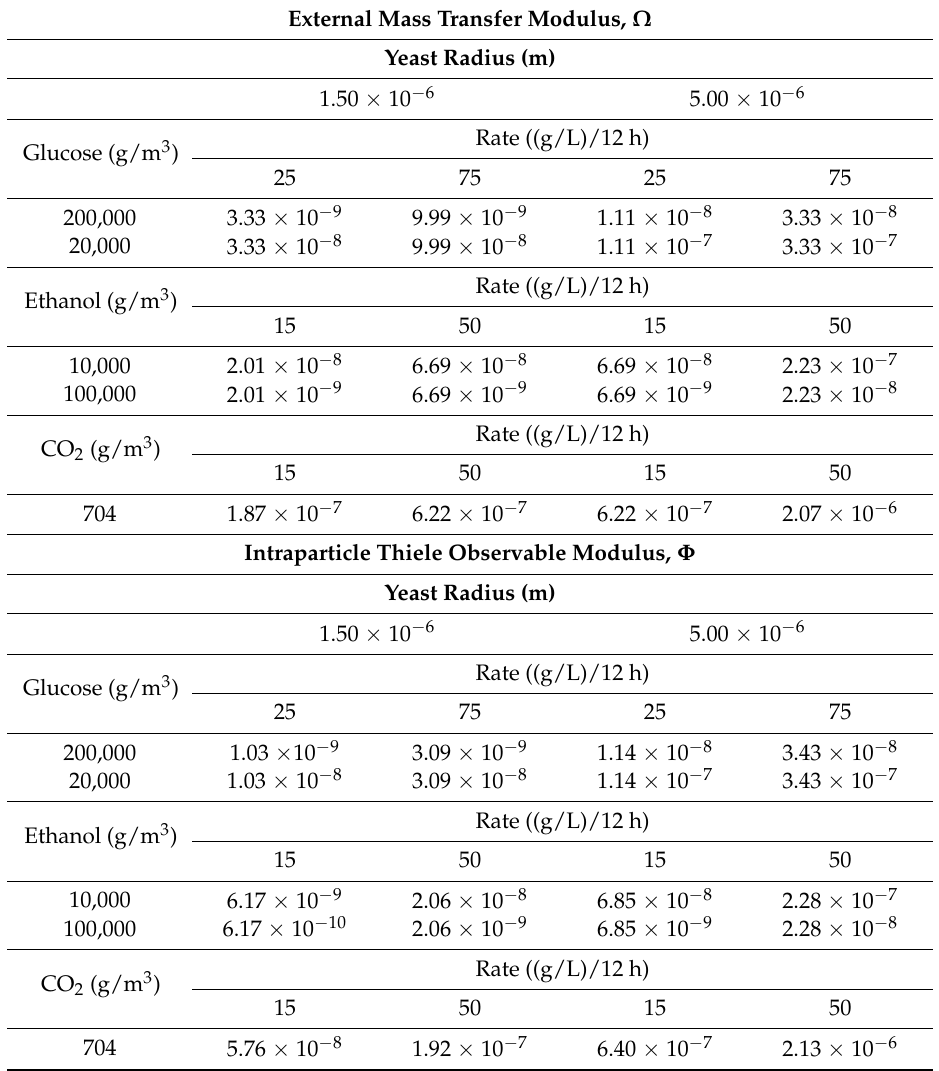
Table 2. Calculated external mass transfer modulus and intraparticle Thiele observable modulus for glucose, ethanol, and carbon dioxide during